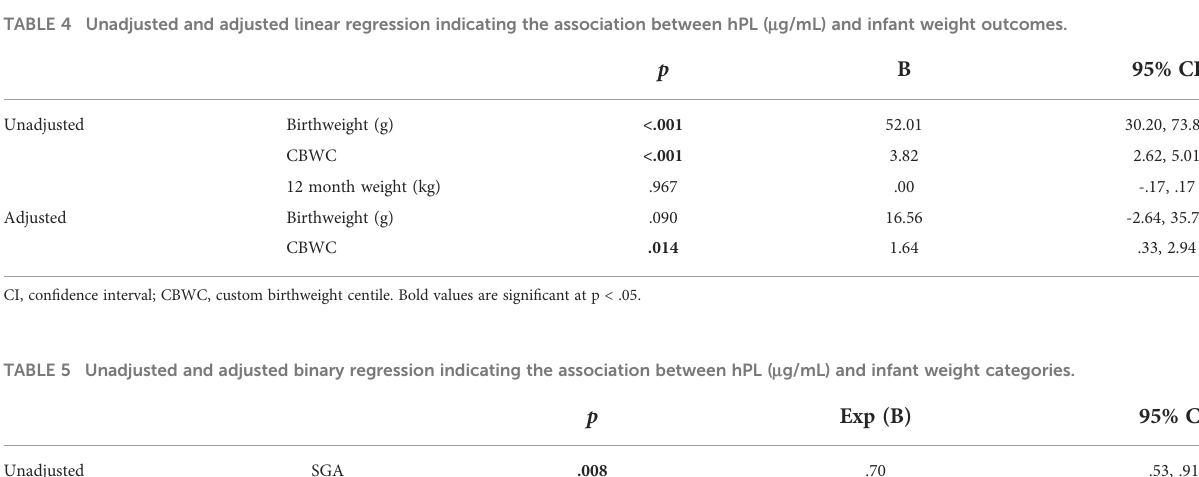
TABLE 4 Unadjusted and adjusted linear regression indicating the association between hPL ( m g/mL) and infant weight outcomes. Unadjusted